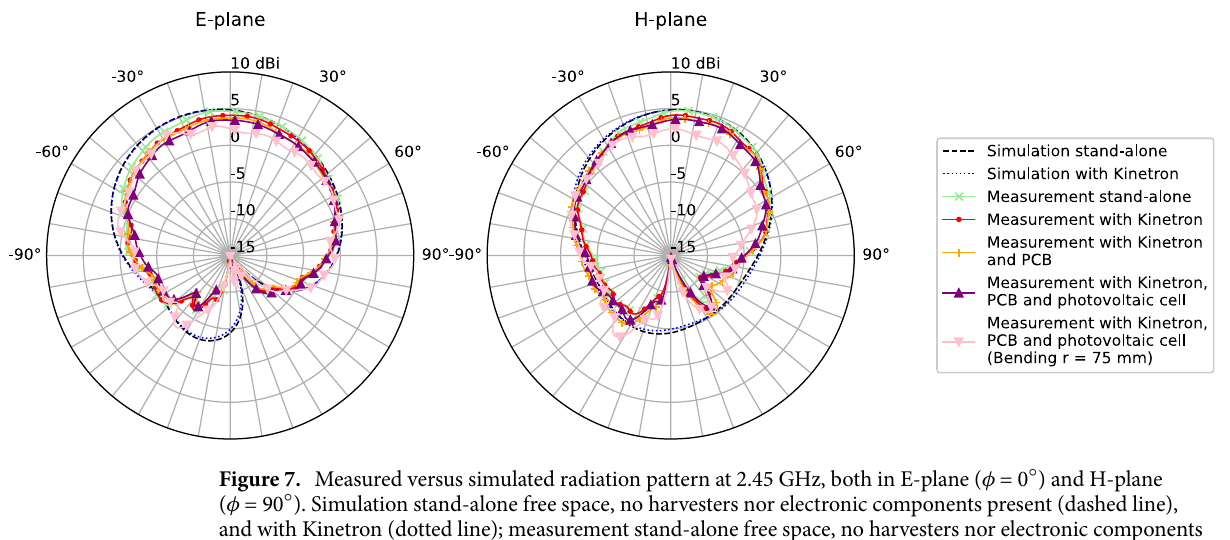
spherical near-field scanner system. Figure 7 shows the simulated and measured far-field gain patterns in the E-plane and H-plane, respectively. Table 1 summarizes these far-field results for different integrated compo- nents. The coaxial cable attached to the connector on the feed plane of the antenna was covered by absorbers to minimize cable effects. The simulated FTBR in stand-alone conditions (free space, no harvesters nor electronic components present) amounts to 9.27 dB and to 9.73 dB when the MGS 32.8 EH is inserted into the substrate. In stand-alone condi- tions (a), the measured maximum gain of 4.95 dBi and gain pattern shape correspond well to the simulation results. Integration of the MGS 32.8 EH (b) results in a slightly lower maximum gain and efficiency in measure- ments due to the approximate model used in simulations for the kinetic harvester. Next, measurements per- formed with the flexible PCB attached to the feed plane of the antenna platform (c) show an additional decrease